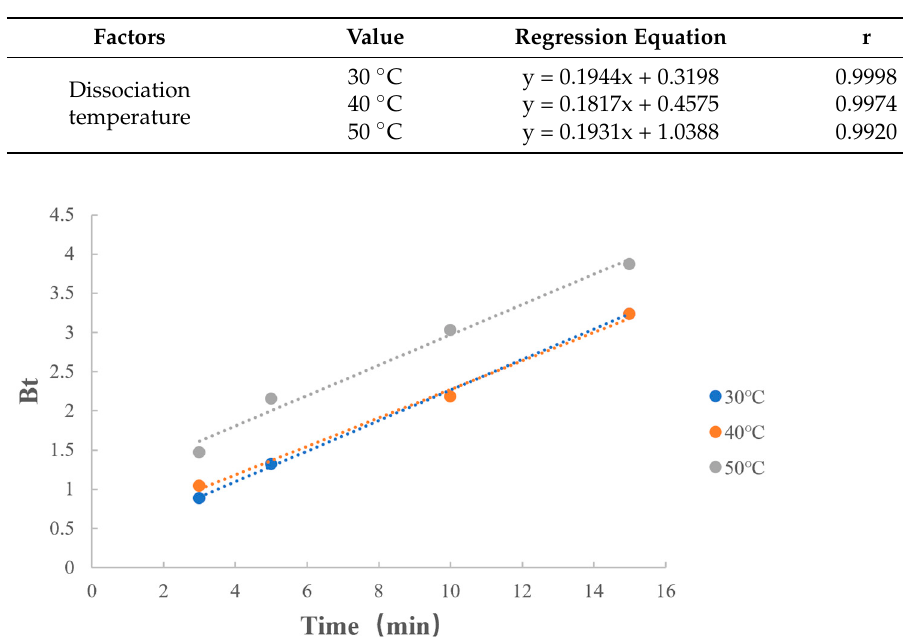
Table 13. Boyd model fitting on dissociation temperature.